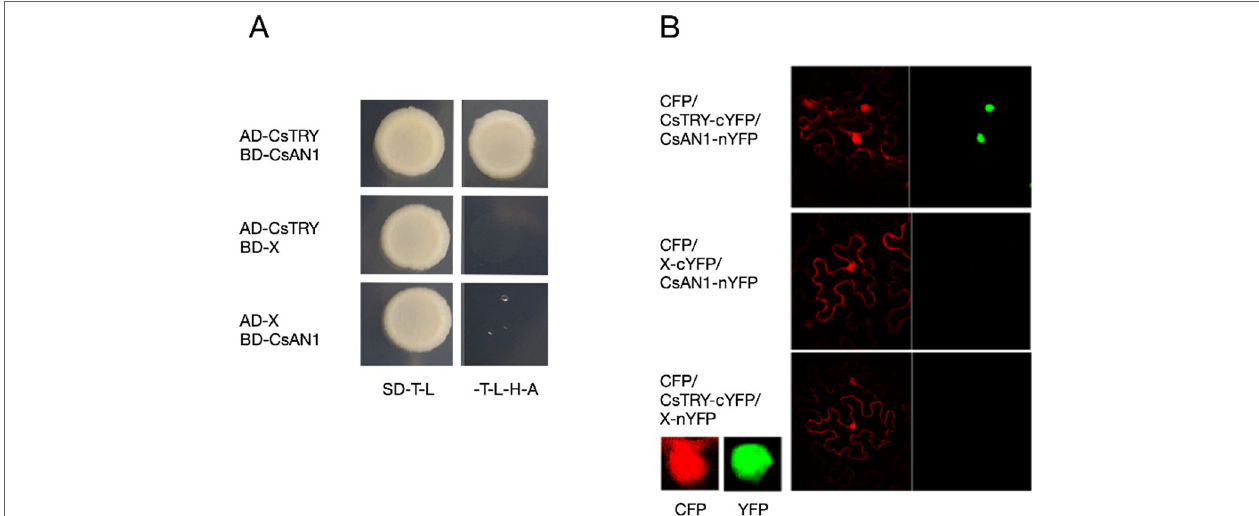
FIgURE 5 | Yeast two-hybrid analysis and BiFC (A) Activation activity of CsTRY to CsAN1 in yeast. (B) BiFC analysis of the physical interaction between CsAN1 (fused with the N-terminal fragment of YFP) and CsTRY (fused with the C-terminal fragment of YFP).